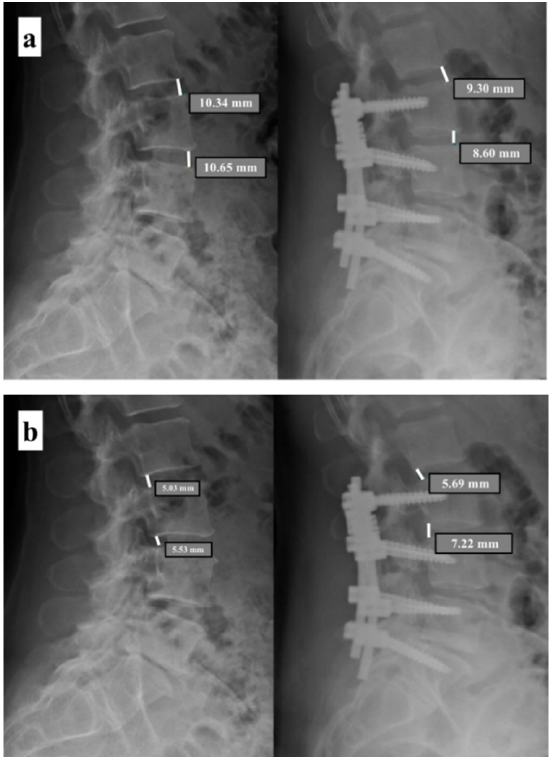
Figure 1. Assessment of discal degeneration. ( a ) Preoperative and postoperative evaluation of the anterior discal heights (ADH) at the dynamized level (DL) and adjacent level (AL). ( b ) Preoperative and postoperative evaluation of the posterior discal heights (PDH) at the dynamized level (DL) and adjacent level (AL).